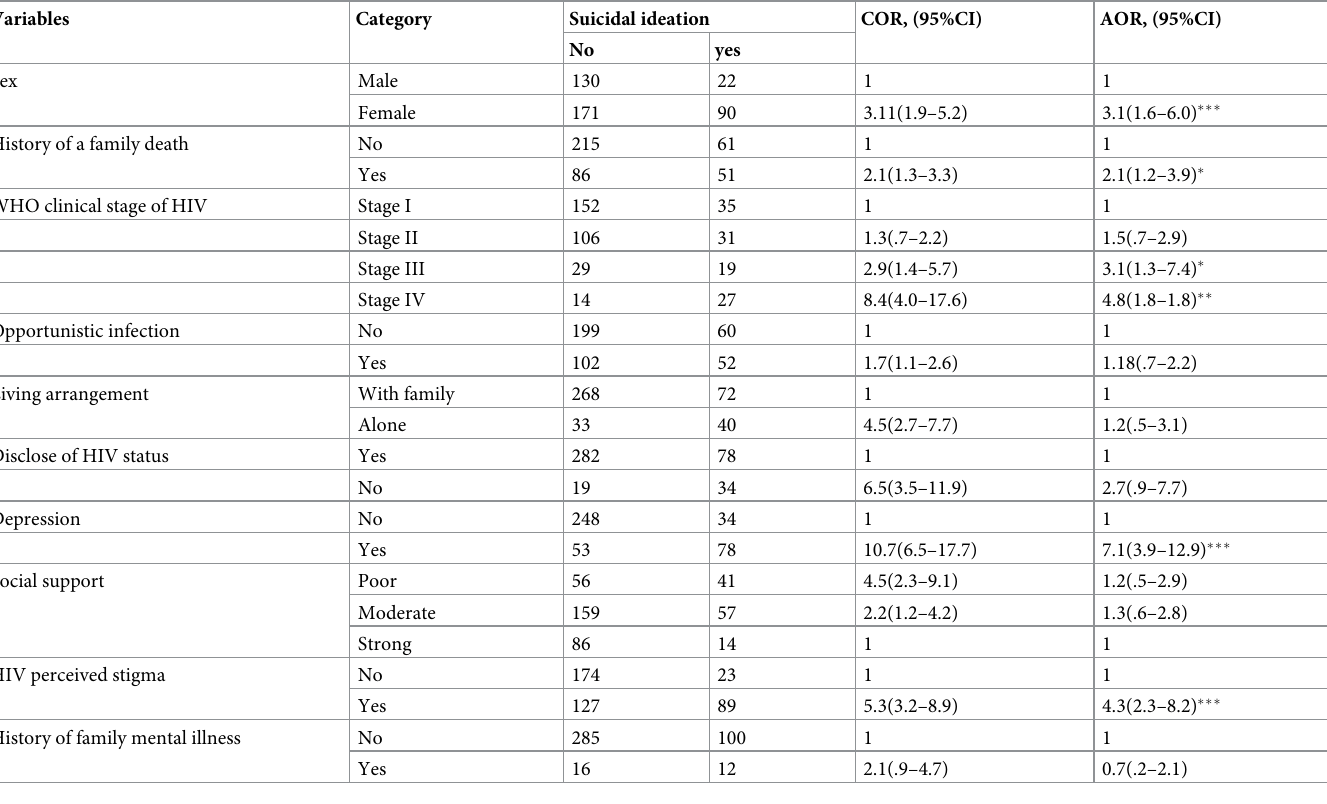
Table 4. Factors associated with suicidal ideation of participants at St. SPSH and SPHMMC Addis Ababa, Ethiopia, 2018 (n =